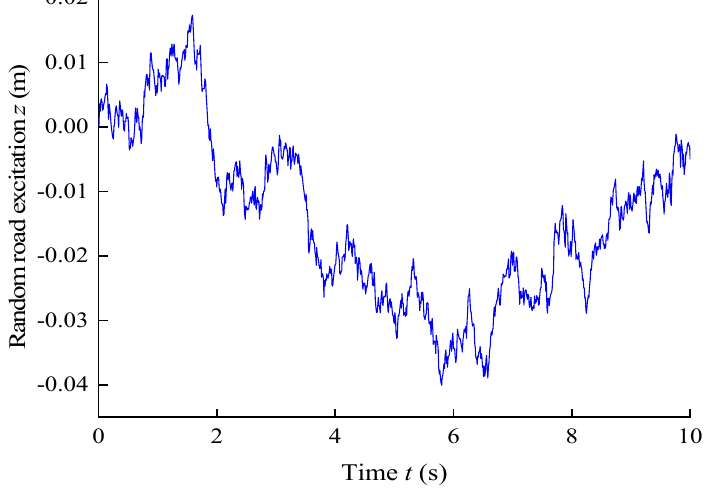
Figure 16. Random input waveform of road surface. Table 3. Model parameters of two-degree-of-freedom quarter vehicle passive air suspension system.